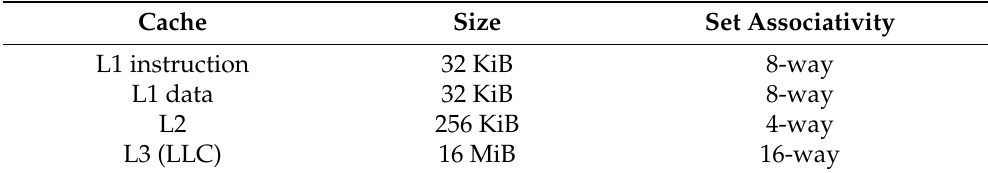
Table 2. Cache Configuration of 8-core Intel